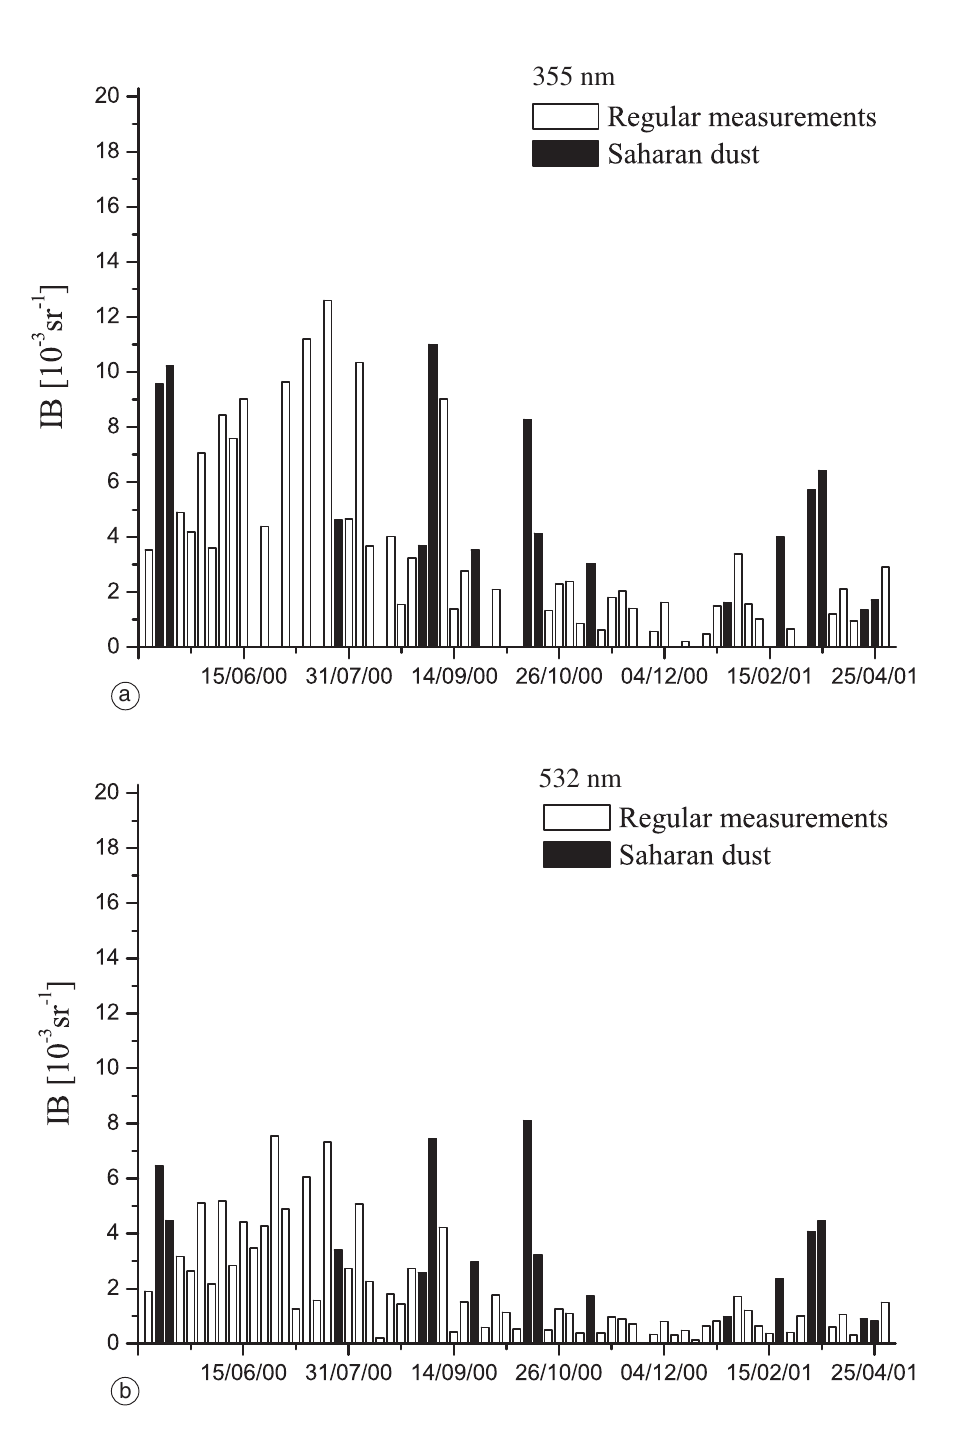
Fig. 7a,b. Integrated aerosol backscatter at 355 nm (a) and 532 nm (b) for all night time lidar measurements in Tito Scalo in the period May 2000-April 2001. Regular measurements are reported in white, Saharan dust measurements are reported in